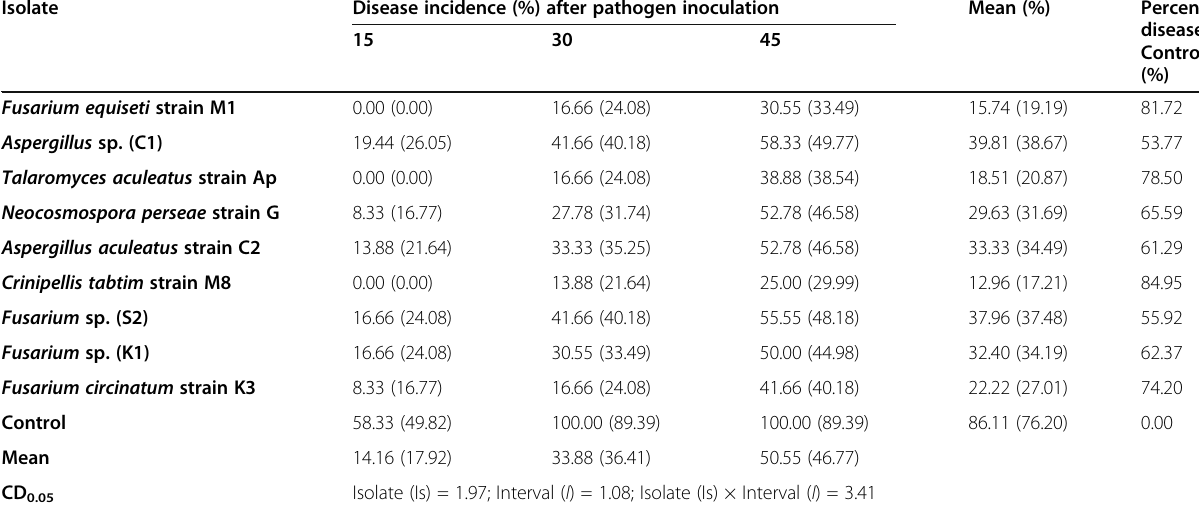
Table 4 Effect of seed treatment with fungal root endophytes on white root rot of apple under field conditions Isolate Disease incidence (%) after pathogen inoculation Mean (%) Percent